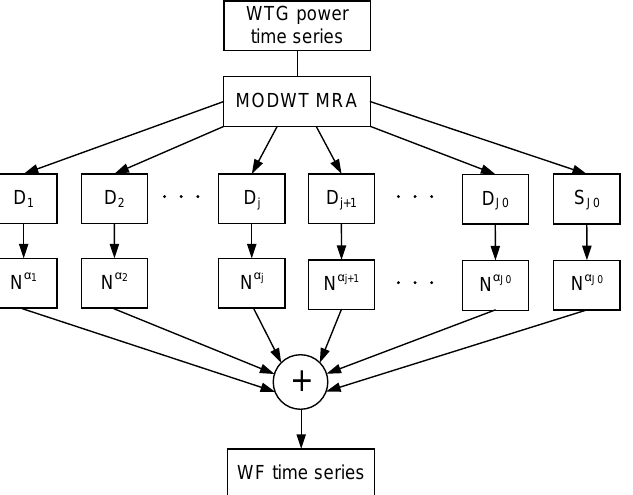
Figure 4. WTG to wind farm power generation model based on MODWT MRA and smoothing characteristics of the underlying wind farm.